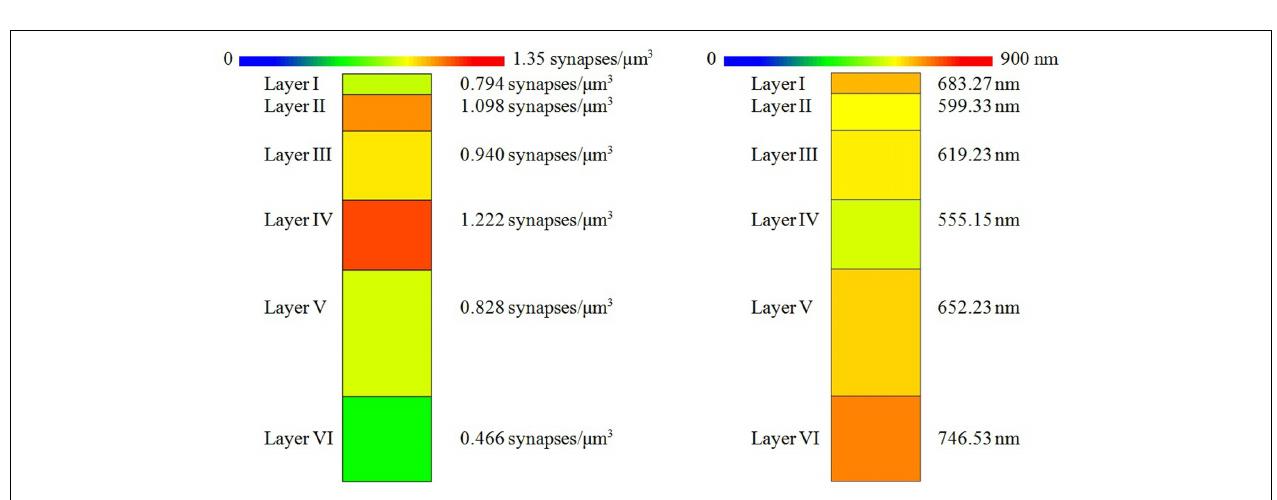
FIGURE 5 | (Left) Mean synaptic density of the six layers of the somatosensory cortex. The synaptic density of the six layers is significantly different. However, we found no significant differences between the densities of layers I vs. V or between the densities of layers II vs. III. (Right)